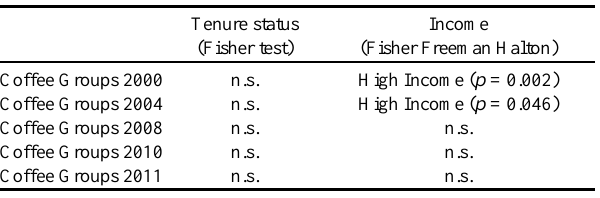
Table 3 . Statistical tests for land tenure and income terciles in coffee groups; n.s.= not statistically